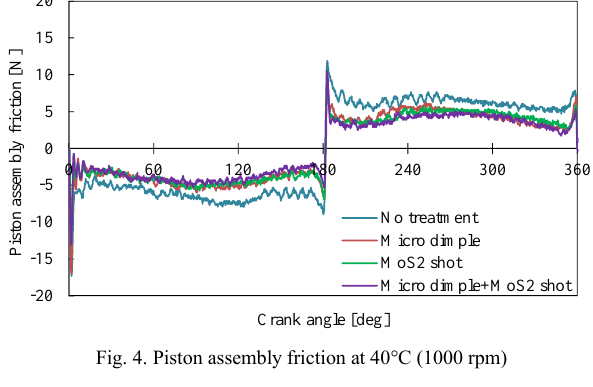
Fig. 7. Stribeck diagram in no treatment (1000 rpm)